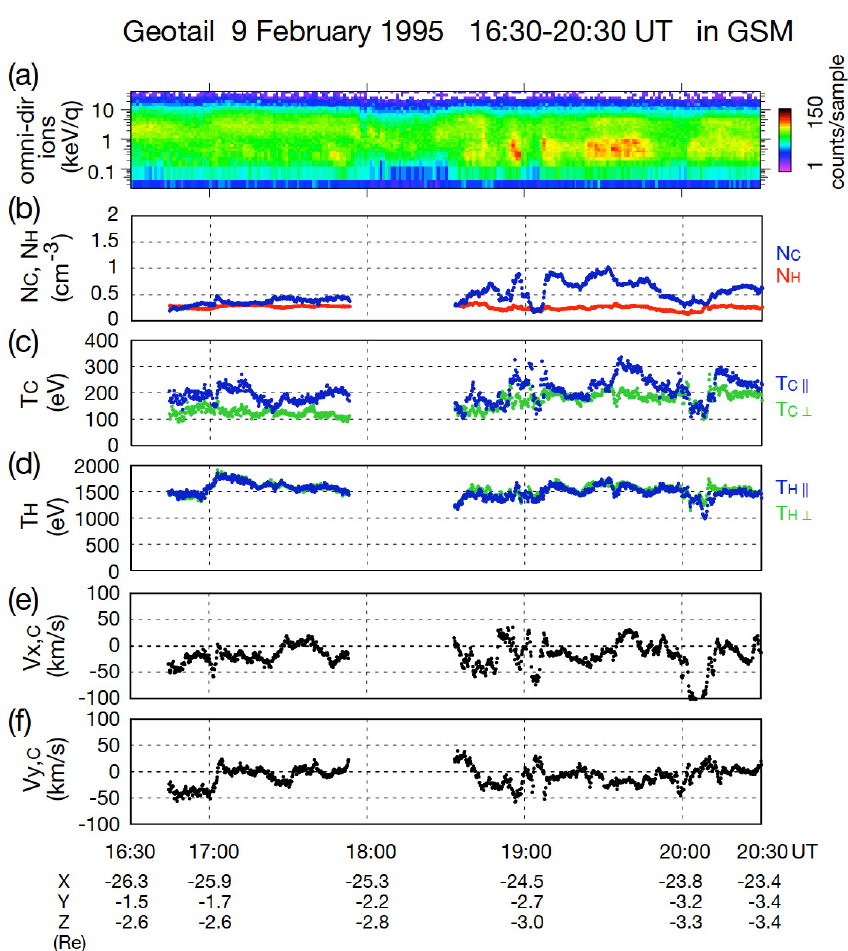
Fig. 9. Expansion of the Geotail observation between 16:30–20:30UT, in the same format as Fig.